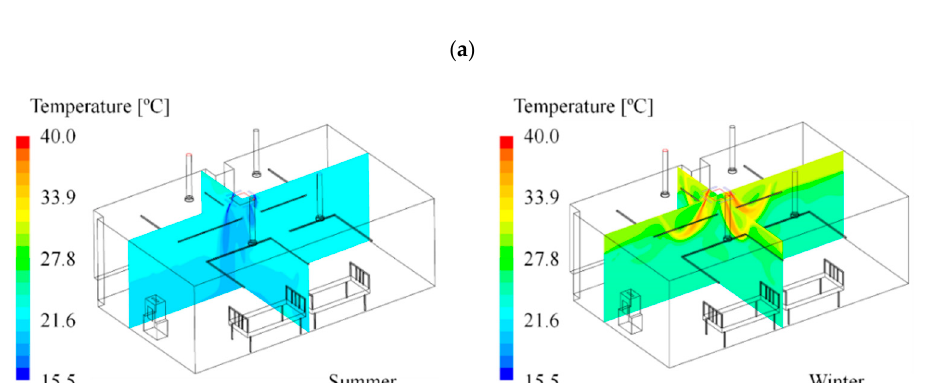
( c ) Figure 3. One of the simulation results ( left : Case S2 in summer, right : Case W2 in winter); ( a ) ve- locity contour; ( b ) temperature contour; ( c ) age of air contour.